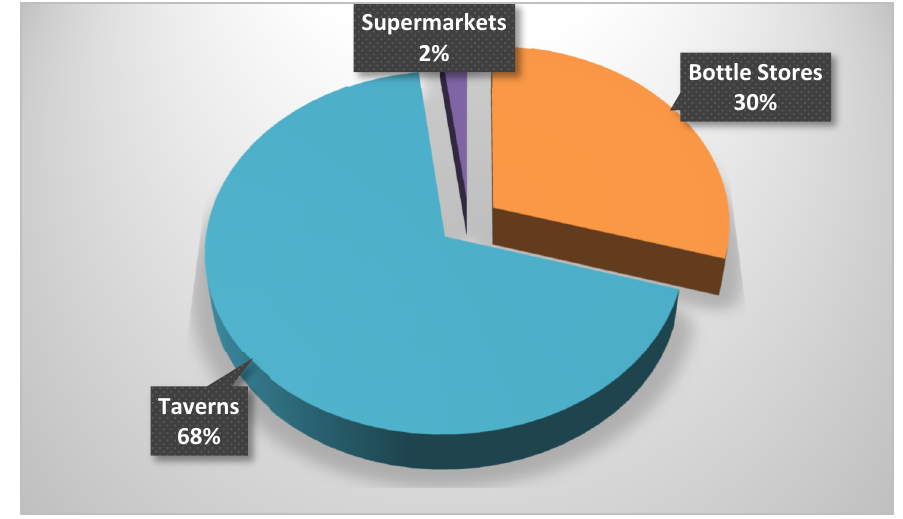
Figure 1. Alcohol outlets for accessibility.